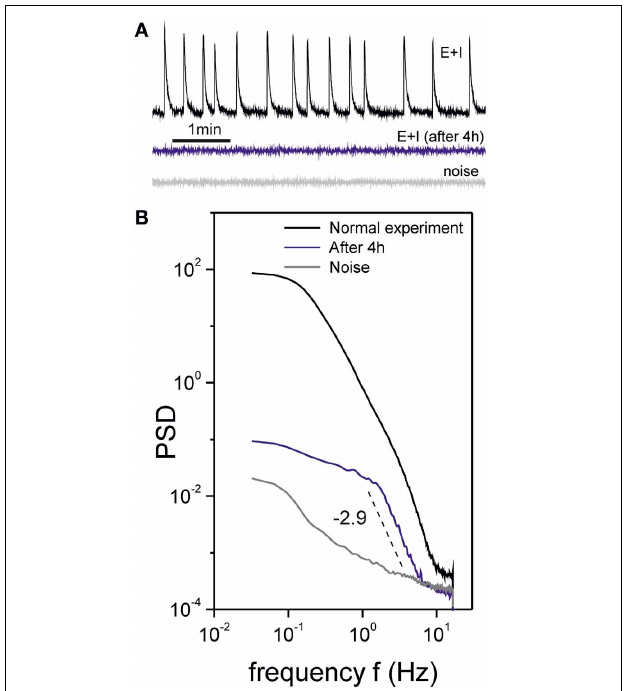
FIGURE 10 | Unhealthy cultures. (A) Traces of fluorescence spontaneous activity in a “E + I” culture recoded in healthy (top) and unhealthy (center) conditions. The unhealthy state was induced by maintaining the culture under continuous light exposure for 4 h, which resulted in the death of several neurons. The unhealthy network showed individual neuronal firing but was deprived of bursting activity. The bottom trace shows the noise of the recording system. (B) Corresponding PSD curves. The unhealthy state shows a trend very different from both the healthy state and the noise, with a scaling at high frequencies that may arise from temporal correlations between individual neuronal